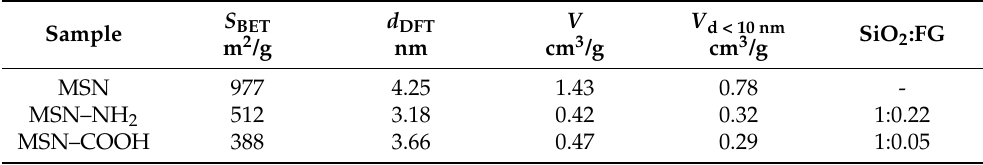
Figure 2. Thermogravimetric analysis of MSN carriers and polyphenolic-extract-loaded MSN. Table 1. Textural parameters of MSN carriers.